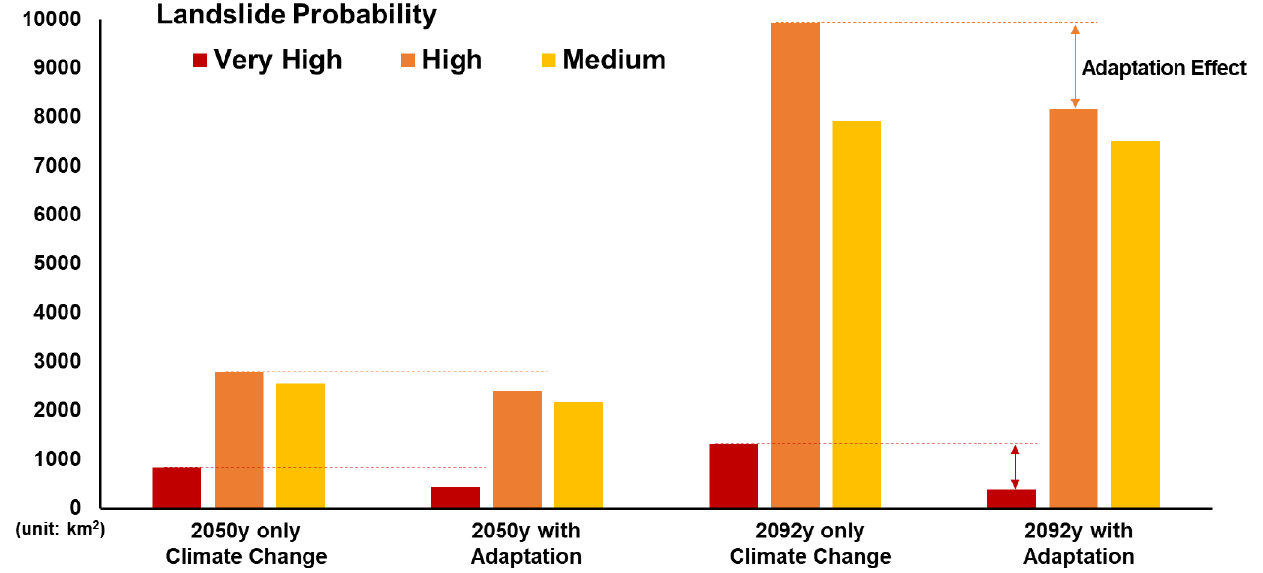
Figure 9. Comparison of landslide probability for identifying the adaptation effect.